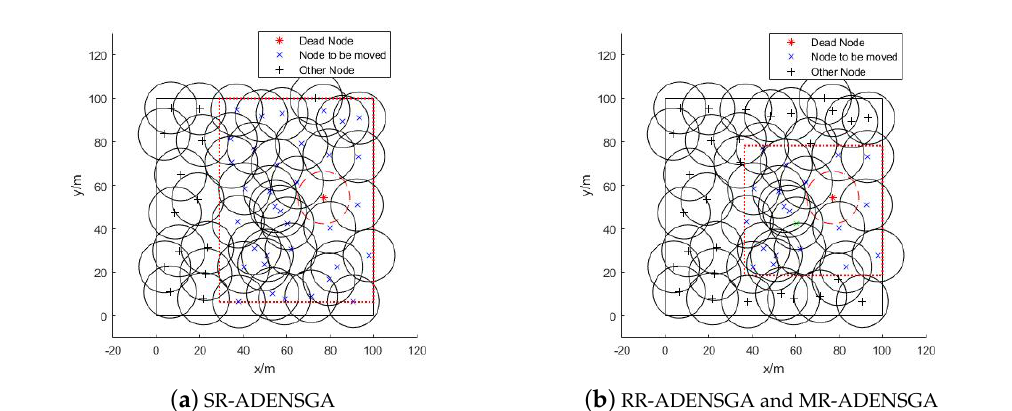
Figure 3. Optimization Region and Position of Nodes to be Moved in Situation 1.